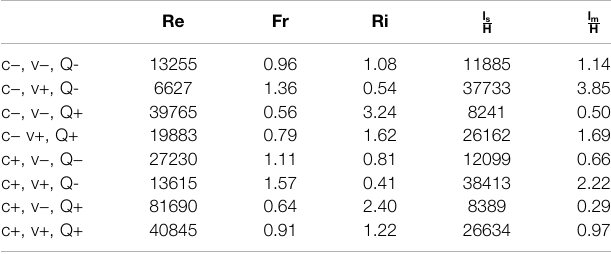
TABLE 1 | Range of dimensionless numbers for the discharge conditions. Values are based on design speci fi cations, – indicates lower bound, + indicates upper bound for concentration c (0.01 – 0.03) (mol/L), vehicle velocity v (0.25 – 0.5) [m/s] and discharged volume Q (0.125 – 0.375) [m 3 /s per meter width]. Values are taken from (Lang et al.,